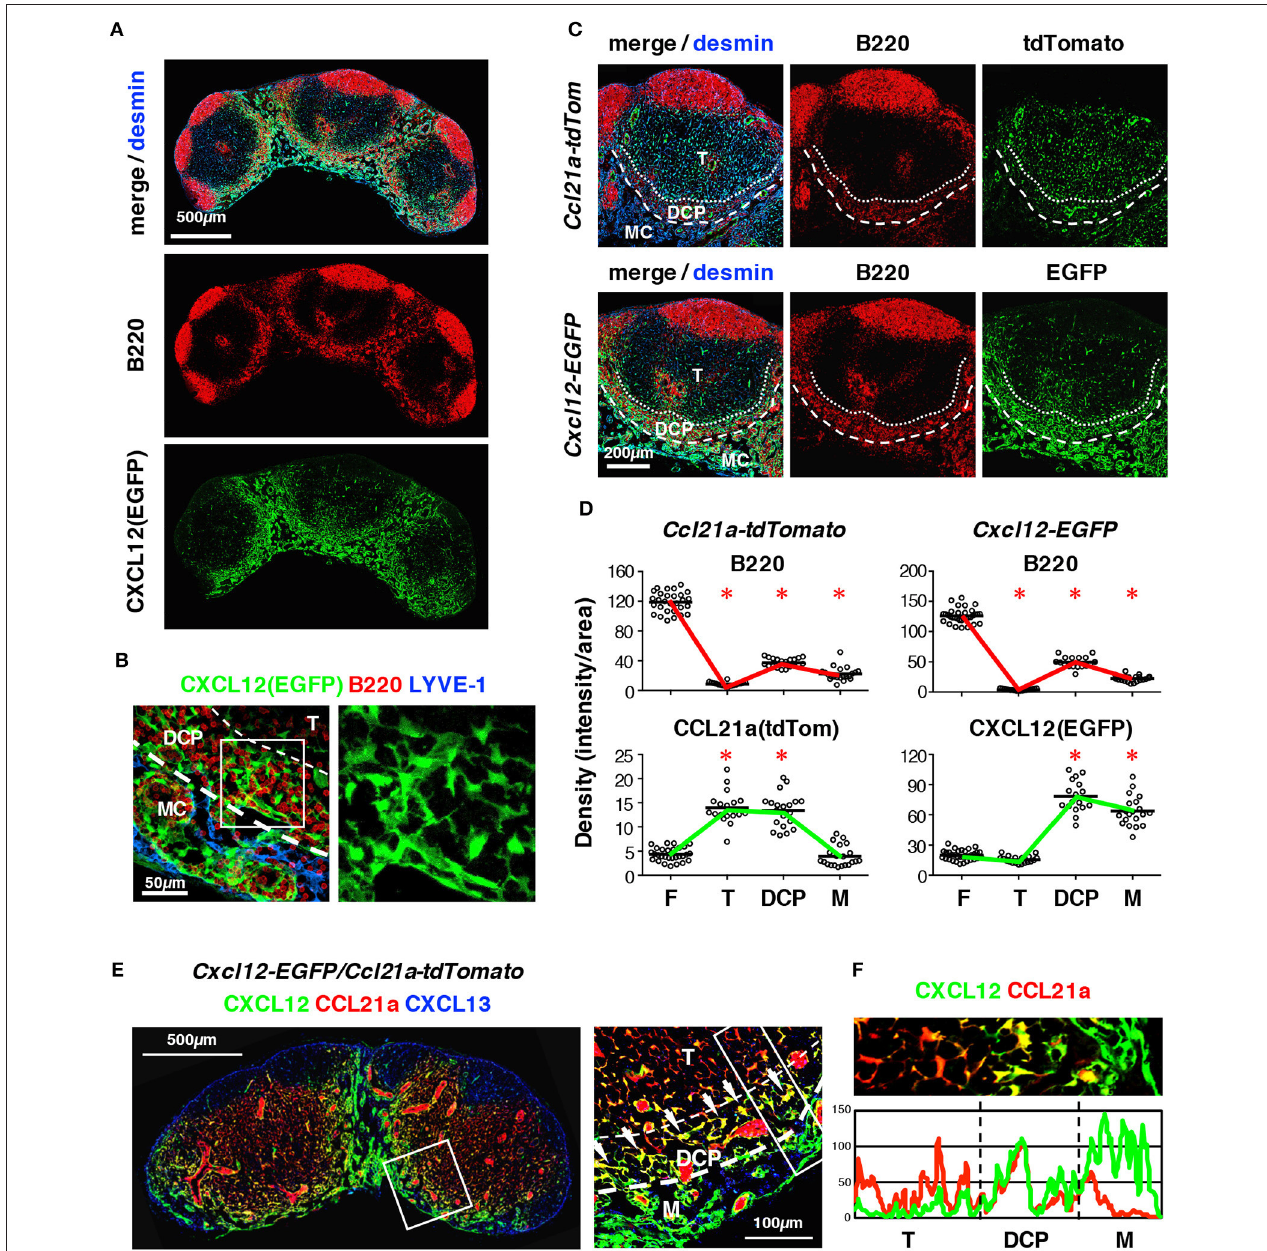
FIGURE 4 | The DRC comprises a unique FSC subset that expresses CXCL12 and CCL21-ser in the DCP of mouse LNs. (A) Enrichment of CXCL12 high FSCs in the DCP and medulla. Section of a cervical LN from a Cxcl12 -EGFP mouse stained for B220 and desmin. (B) Z-projection image (0.5 µ m interval × 10) of the DCP and medulla. Boxed area is magnified in the right panel (EGFP only), showing the dense network of DRCs. (C) Comparative views of FP expression in the DCP between Ccl21a -tdTomato and Cxcl12 -EGFP mouse strains. (D) Quantitative analysis of signal densities in LN subcompartments in Ccl21a -tdTomato and Cxcl12 -EGFP mice (bars, mean; asterisks, significantly different compared to the follicles, p < 0.0001). (E) Inguinal LN section from Cxcl12 -EGFP/ Ccl21a -tdTomato mouse with staining for CXCL13. The boxed area in left micrograph is magnified on the right. Bright yellow signals (arrows) indicate the cells highly expressing both CXCL12